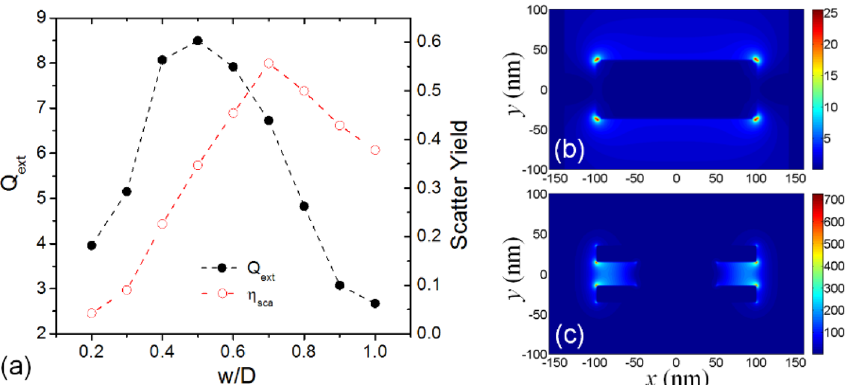
Figure 3. ( a ) Dependence of magnitude of extinction efficiency and scattering quantum yield on the fractional width of bridge, and calculated distribution of E-field intensity around the multilayered disc ( b ) before and ( c ) after the Cu bridge formation at each resonance maximum.